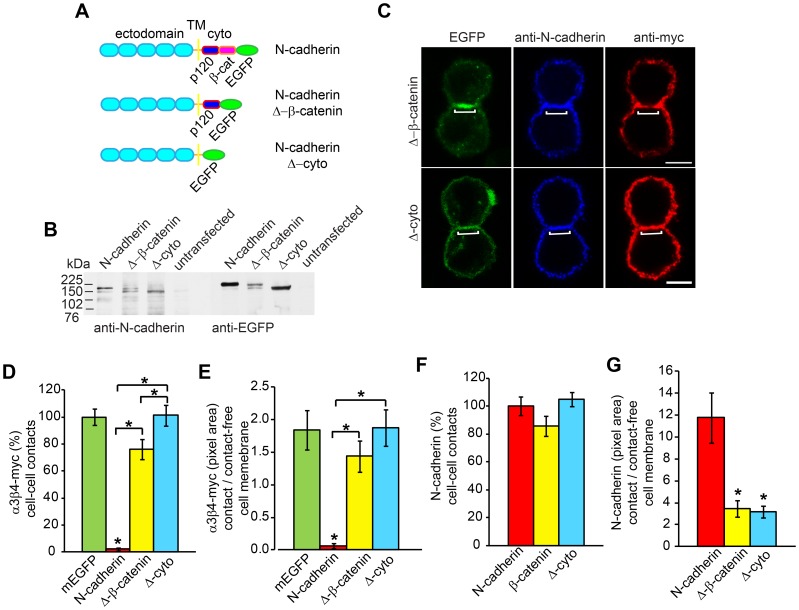
N-cadherin cytoplasmic domain is required to regulate α3β4-myc nAChRs localization on the cell surface.A) Schematic drawings of the N-cadherin constructs used in this study. Full length N-cadherin (N-cadherin) comprised of the ectodomain, the transmembrane domain (TM), and the cytoplasmic domain (cyto). N-cadherin with a deleted β-catenin (β-cat) binding region (N-cadherin-Δ-β-catenin), and N-cadherin with a deletion of the entire cytoplasmic domain (N-cadherin-Δ-cyto) lacks both the p120-catenin (p120) and α-catenin binding regions. The three constructs were C-terminally fused to EGFP. B) Western blot analysis of expression of full length N-cadherin and N-cadherin-deleted proteins in CHO cell homogenates immunoblotted with anti-N-cadherin (NCD2) and anti-EGFP antibodies. C) Confocal images of CHO cells expressing N-cadherin-Δ-β-catenin or N-cadherin-Δ-cyto and α3β4-myc nAChRs. Cells were cell surface labeled with anti-N-cadherin (NCD2) and anti-myc antibodies (9B11). Brackets indicate the cell-cell contact area. D) Analysis of pixel density of α3β4-myc nAChRs within the cell-cell contact area in CHO cells expressing mEGFP (n = 24), N-cadherin (n = 22), N-cadherin-Δ-β-catenin (n = 25), or N-cadherin-Δ-cyto (n = 27). α3β4-myc nAChRs pixel density within the cell-cell contact area between cells expressing mEGFP was considered 100%. E) Ratio of α3β4-myc nAChRs pixel density between the cell-cell contact area and the contact-free cell membrane. F) Analysis of the expression levels of N-cadherin-deleted constructs, N-cadherin-Δ-β-catenin (n = 25) and N-cadherin-Δ-cyto (n = 27), at the cell-cell contact membrane compared to the expression levels of N-cadherin (100%) (n = 22). G) Ratio of pixel density between the cell-cell contact and the contact-free cell membrane for N-cadherin, N-cadherin-Δ-β-catenin, and N-cadherin-Δ-cyto deleted constructs immunolabeled with anti-N-cadherin antibodies (NCD2). Values in D, E, F and G represent the mean ± SEM of each experimental group. One-way ANOVA in D, E, and G, p<0.001, and in F, p>0.05; post-hoc Bonferroni test comparisons with mEGFP (D and E) or N-cadherin (G), *p<0.05. Bars with an asterisk indicate post-hoc Bonferroni test comparison between the two indicated groups, p<0.05. Scale bars, 5 µm.